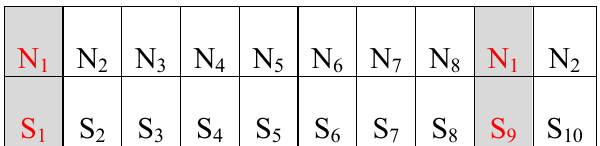
Fig. 5 Critical data selection of each frame for 8 node